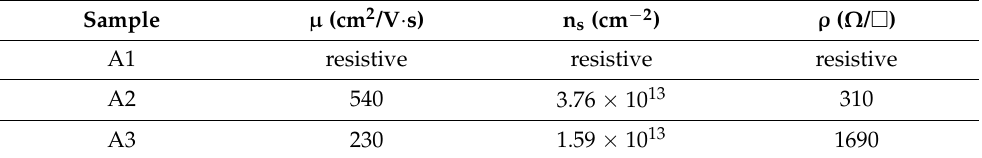
Table 3. The 2DEG properties, electron mobility, sheet charge, and sheet resistance, of AlN/GaN heterostructures with LT AlN determined through room temperature Hall measurements.